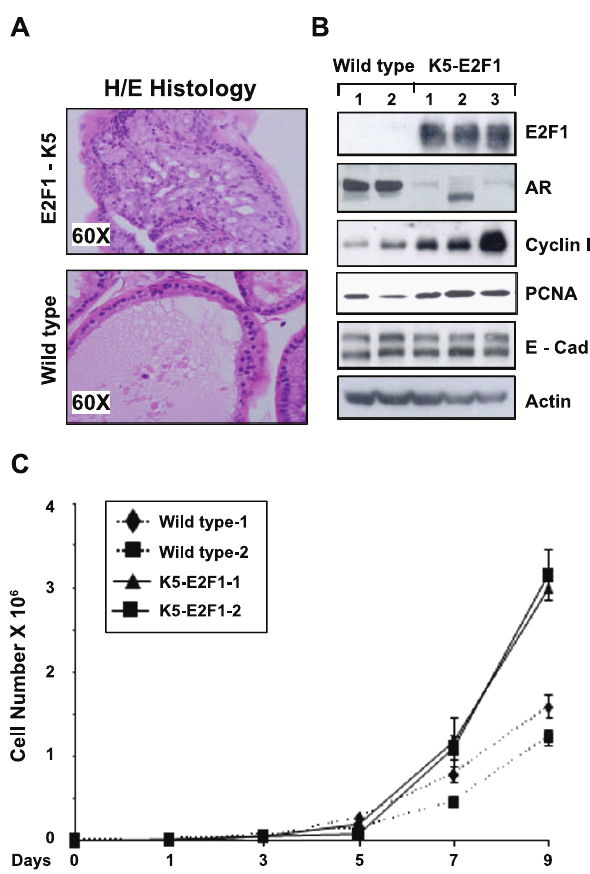
Figure 1. E2F1 leads to atypical prostatic morphology and increases prostate epithelial proliferation in a K5-E2F1 trans- genic mouse. (A) Histology of prostate tissue taken from both K5-E2F1 transgenic and wild type mice. (B) Prostate epithelial cell lines established from both transgenic and wild type mice were analyzed by western blot for the expression of E2F1, cell cycle genes (Cyclin E and PCNA), the epithelial cell specific marker E-cadherin (E-cad), and Androgen Receptor (AR). Actin is shown as a loading control. (C) A trypan blue exclusion assay was implemented to measure the viability of cell lines obtained from the mouse models. Each point represents the mean of three independent experiments with the standard deviation.